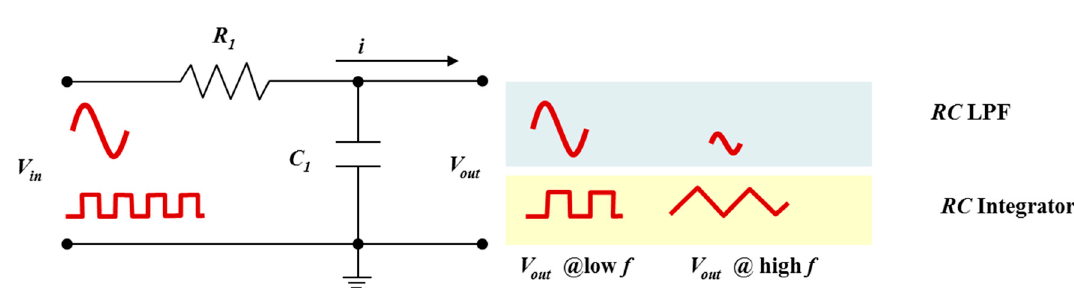
Figure 1. Passive first-order resistor-capacitor ( RC ) low-pass filter (RC-FO) for attenuating higher frequencies ( f > f ) or performing wave shaping (i.e., RC integrator circuit).